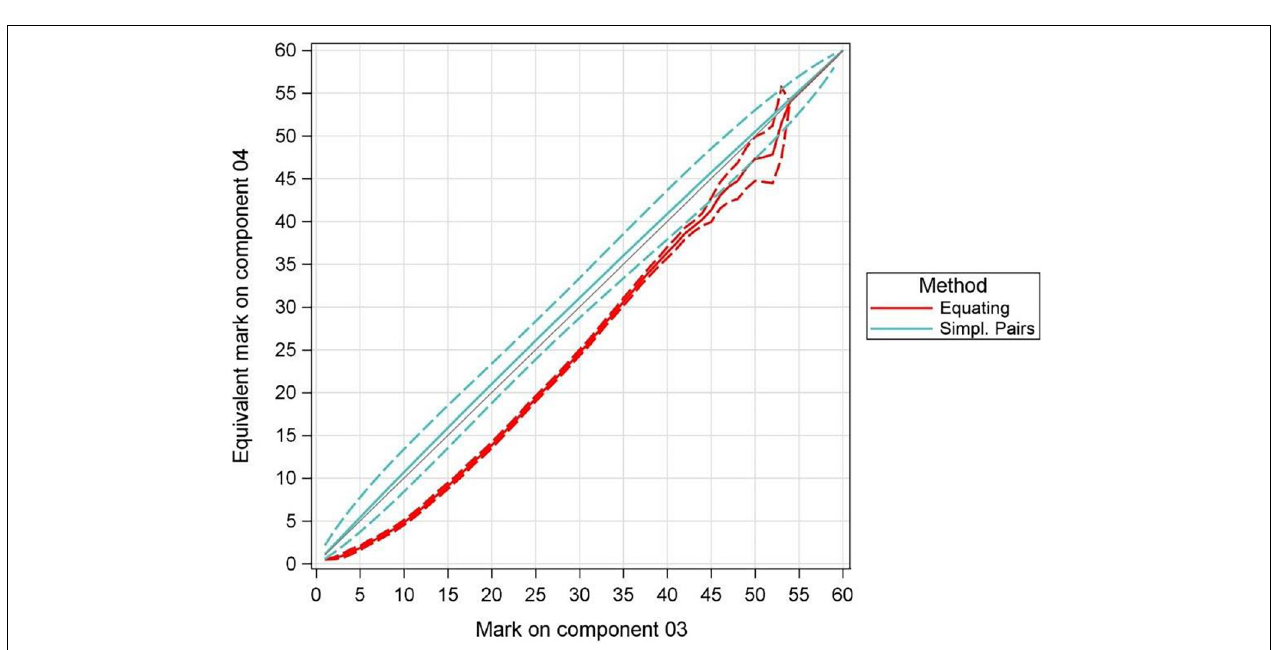
FIGURE 7 | Results of both equating and simplified pairs across the score range